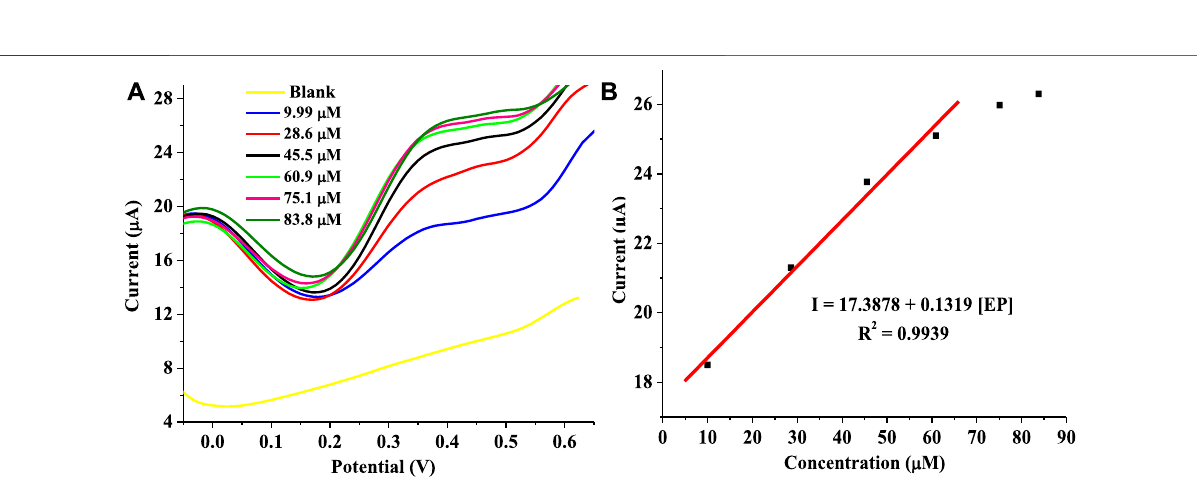
Frontiers in Sensors |